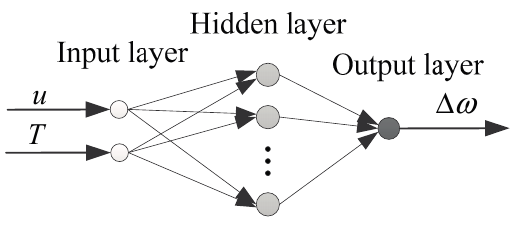
Figure 3. The model of RBF neural network.